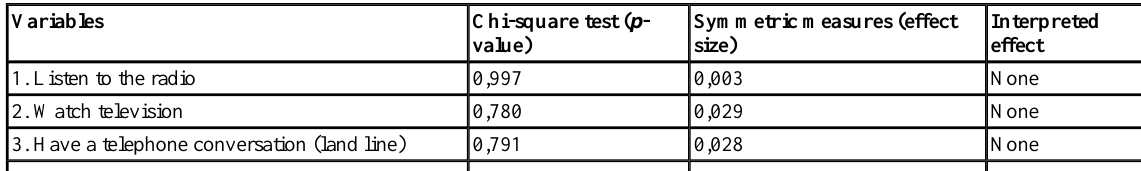
Table 2 Effect of gender on the ICT access and usage patterns of alumni of